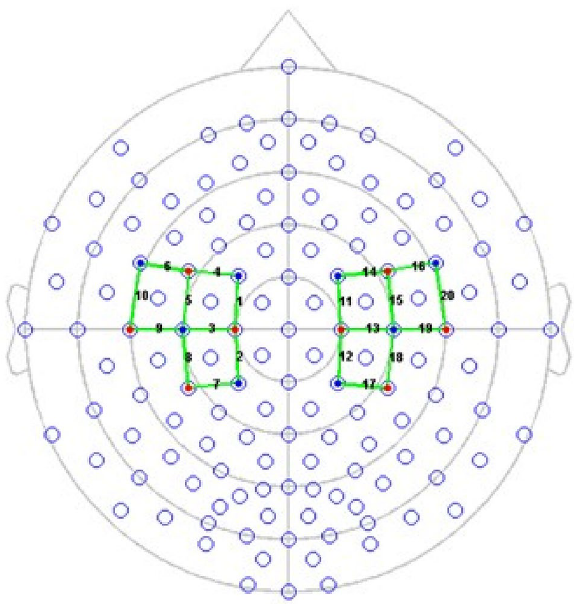
Figure 1. Channels and optodes configuration. Red circles indicate sources. Blue circles represent detectors. Green lines show the recording